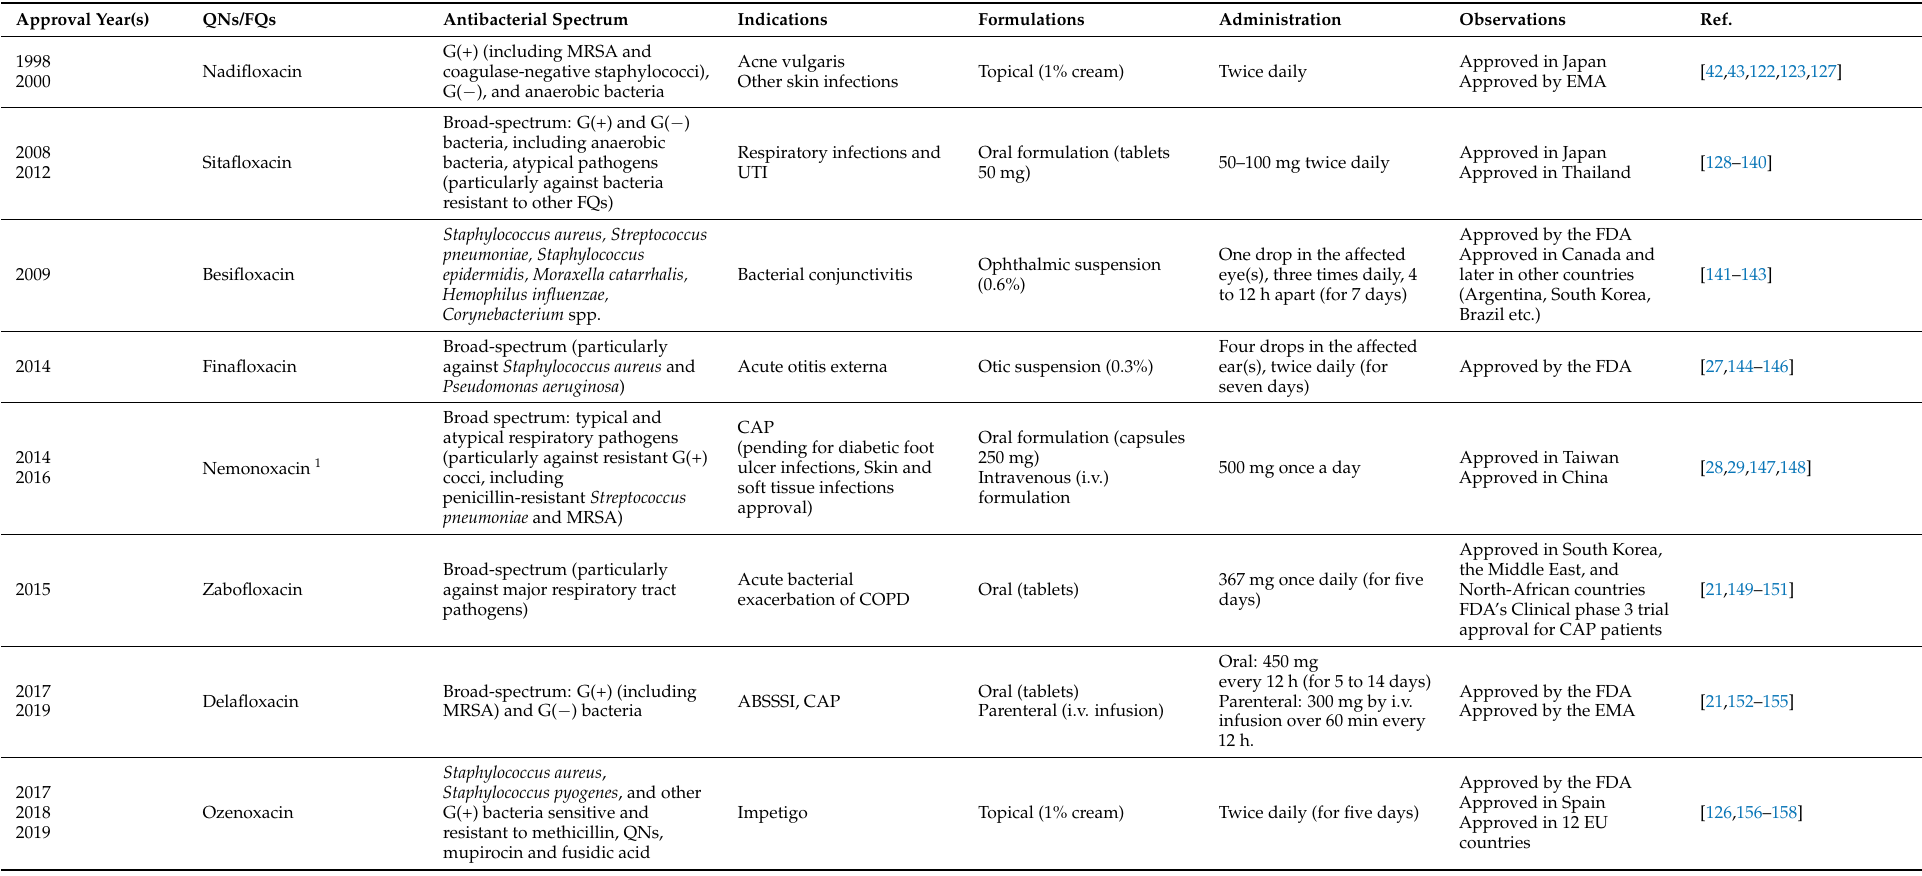
Table 4. Essential information about modern FQs introduced in therapy (ABSSSI—acute bacterial skin and skin-structure infections, CAP—community-acquired pneumonia, COPD—chronic obstructive pulmonary disease, FQs—fluoroquinolones, G(+)—Gram-positive, G( − )—Gram-negative, MRSA—methicillin-resistant Staphylococcus aureus , QNs—antibacterial quinolones,